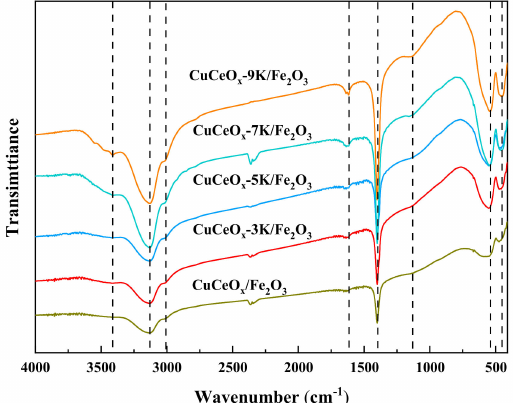
Figure 6. FT-IR profile of the CuCeO x -xK/Fe 2 O 3